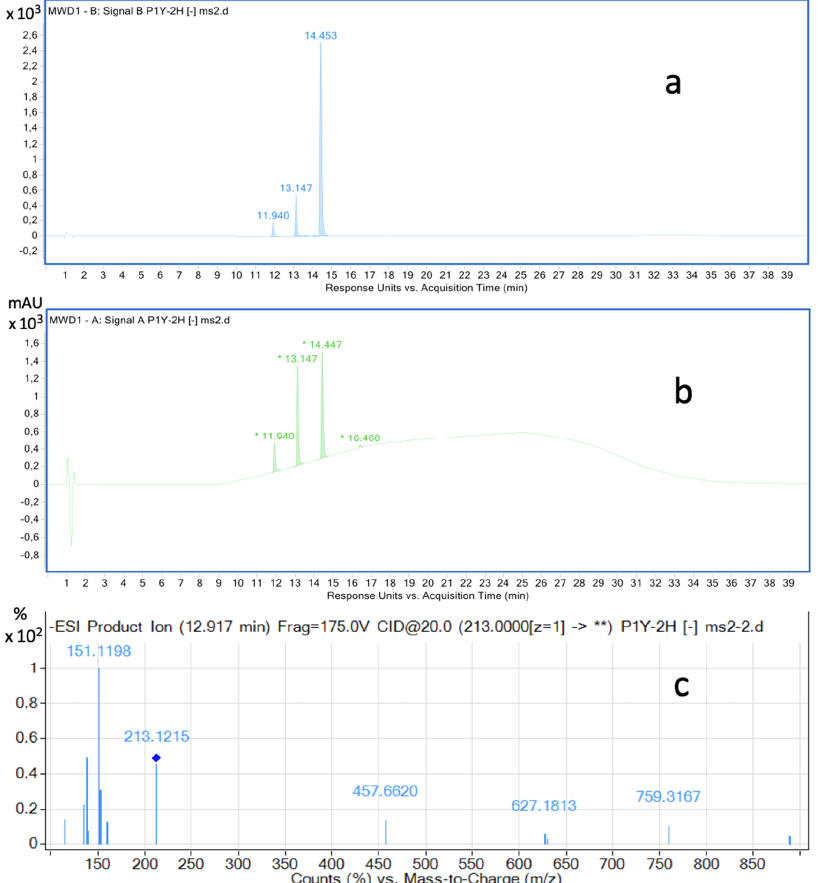
Figure 1. Chromatograms of the components of the Rhodococcus sp. P1Y culture liquid 2 h after adding the tritium labeled ABA. HPLC-MS, registration at two wavelengths: 254 nm ( a ) and 220 nm ( b ). Mass spectra of components: ESI–TOF MS, negative ion mode ( c ), E col = 20 V m/z (relative intensity): compound 14.4, abscisic acid (ABA): 263.1291 (C 15 H 19 O 4 , calcd. 263.1283) [M-H] − (100), 219.1392 (C 14 H 19 O 2 , calcd. 219.1385) [M-H-CO 2 ] − (14); Compound 13.1 (metabolite I) ( с ): 213.1203 (C 11 H 17 O 4 , calcd. 213.1127) [M + 2H 2 O- H-CH 3 CHO] − (45), 153.0951 (C 9 H 13 O 2 , calcd. 153.0916) (31), 151.1198 (C 10 H 15 O, calcd. 151.1123) (100), 138.0747 (C 8 H 10 O 2 , calcd. 138.0681) (49), 135.0874 (C 9 H 11 O, calcd. 135.0810) (22); compound 11.9: 212.1002 ( 13 C- Isotope ion, calcd. 212.1004) [M-H + 1] − (12), 211.0969 (C 11 H 15 O 4 , calcd. 211.0970) [M-H] − (100), 167.1077 (C 10 H 15 O 2 , calcd. 167.1072) [M-H-CO 2 ] − (41), 152.0834 (C 9 H 12 O 2 , calcd. 152.0837) [M-CH 3 COOH] − (8), 149.0972 (C 10 H 13 O, calcd. 149.0966) [M-H-CO 2 - H 2 O] − (9).